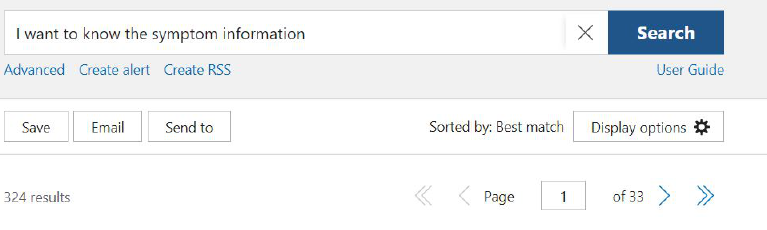
Figure 7. Results of general keywords in systems with